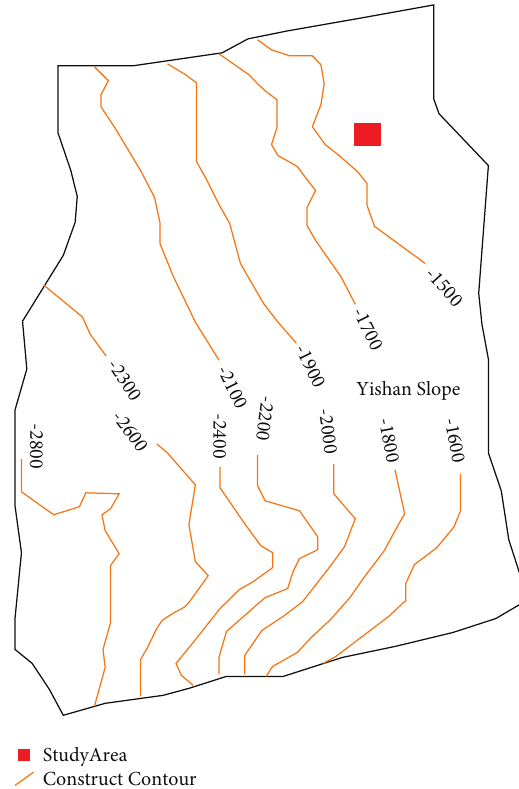
Figure 1: Location of the study area and structure